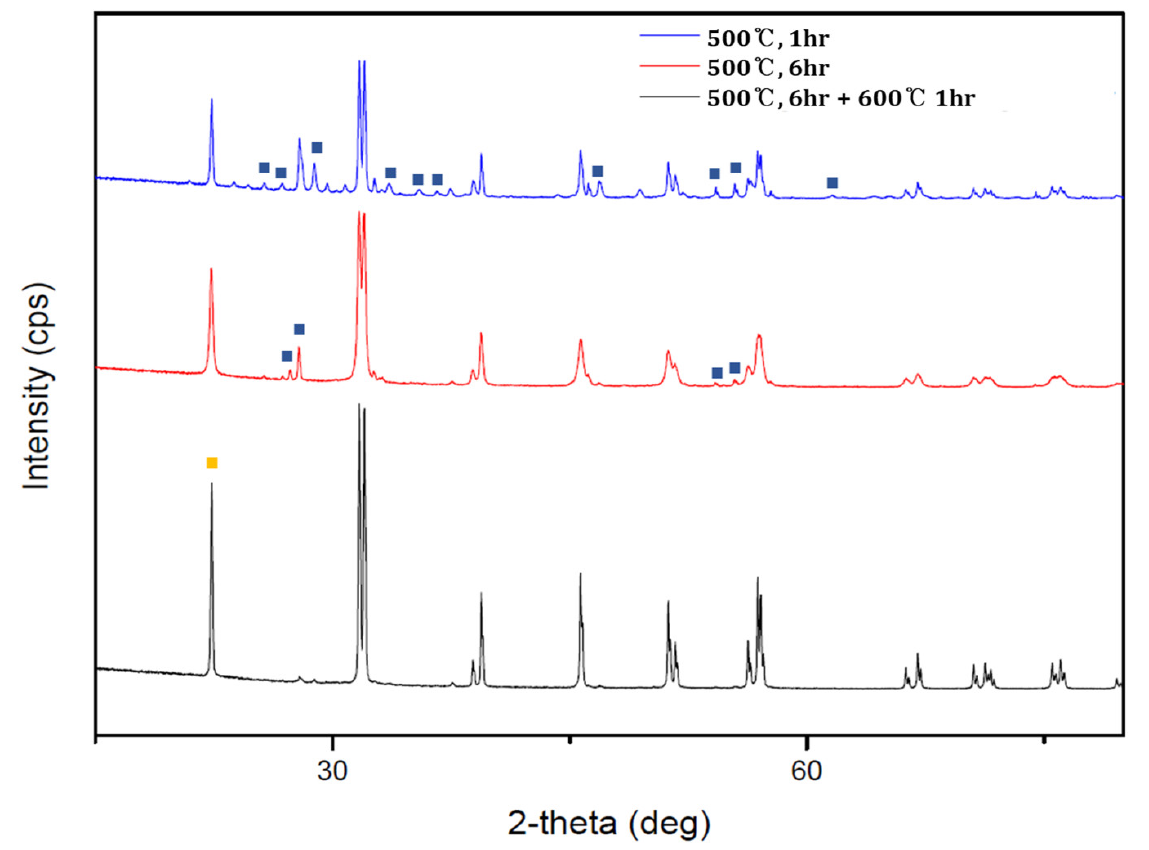
Figure 1. XRD spectra of the BiFeO 3 samples heat-treated at different temperatures. Solid blue square represents Bi 2 O 3 impurity phase and solid orange square represents pure BiFeO 3 phase.